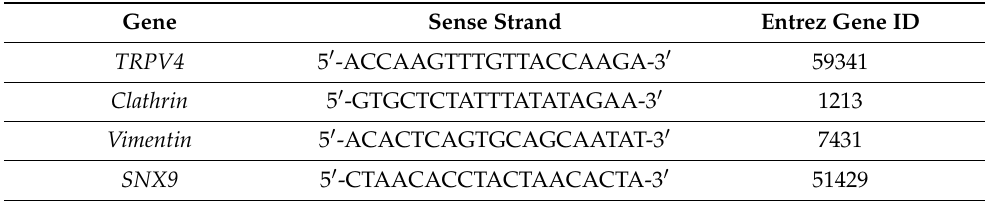
Table 1. Sense Strand of Sequences for Posttranscriptional Gene